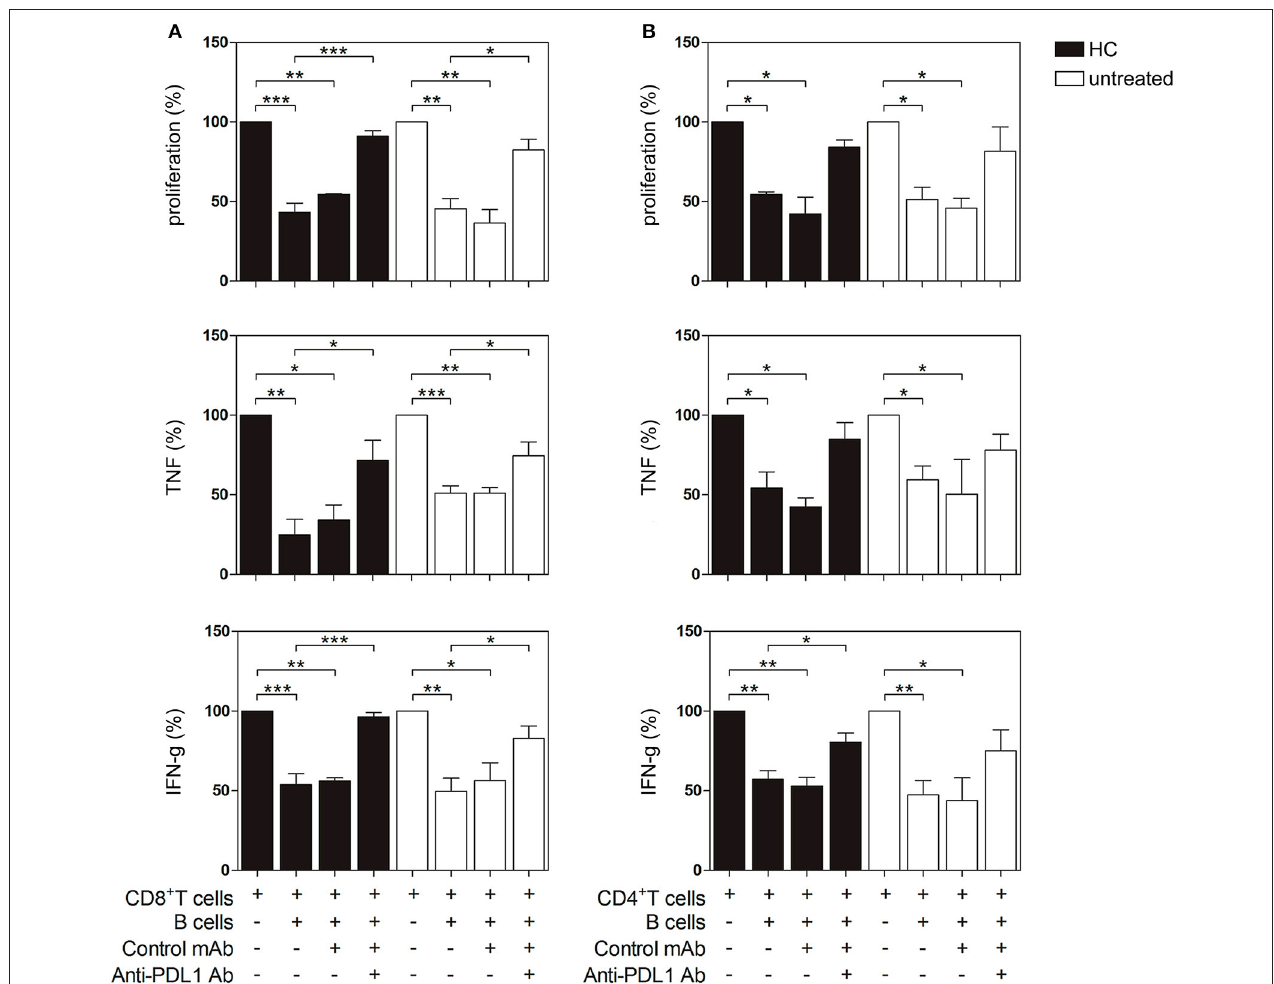
FIGURE 5 | PD-L1-dependent suppression of T cell proliferation and cytokine production by PD-L1 expressing B cells from HC and untreated RA patients. CD19 + B cells, CD8 + and CD4 + T cells were magnetic bead-purified from PBMC of HC and untreated RA patients. CD19 + B cells were incubated with CpG + IL-2 for 72h and then were washed and cultured 2:1 with autologous CFSE-labeled CD8 + or CD4 + T cells incubated in a plate-bound anti-CD3/anti-CD28 mAb in the presence of anti-PD-L1 mAb or control isotype. After 72h of co-culture, T cell proliferation and intracellular cytokine production were analyzed by flow cytometry on CD3 + CD19 − lived cells. Percentage of proliferation, TNF and IFN-g production in (A) CD8 + T cells and (B) CD4 + T cells cultured alone or in the presence of CpG-activated CD19 + B cells with anti-PD-L1 mAb or control isotype. Mean ± SEM of five independent experiments (5 healthy controls and 5 untreated RA patients). * p < 0.05, ** p < 0.01, *** p < 0.001. One-way ANOVA followed by a Bonferroni’s post-test were